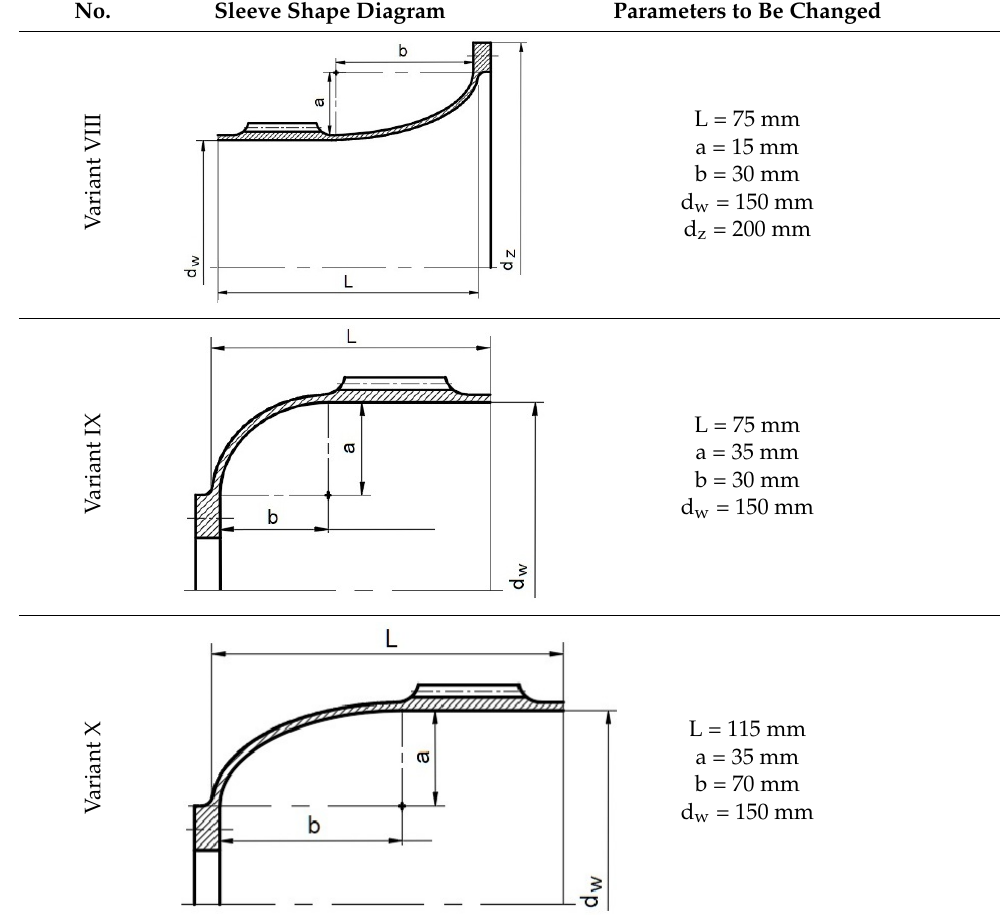
Figure 5. The distribution of the stresses in the flexspline base model—variant I.